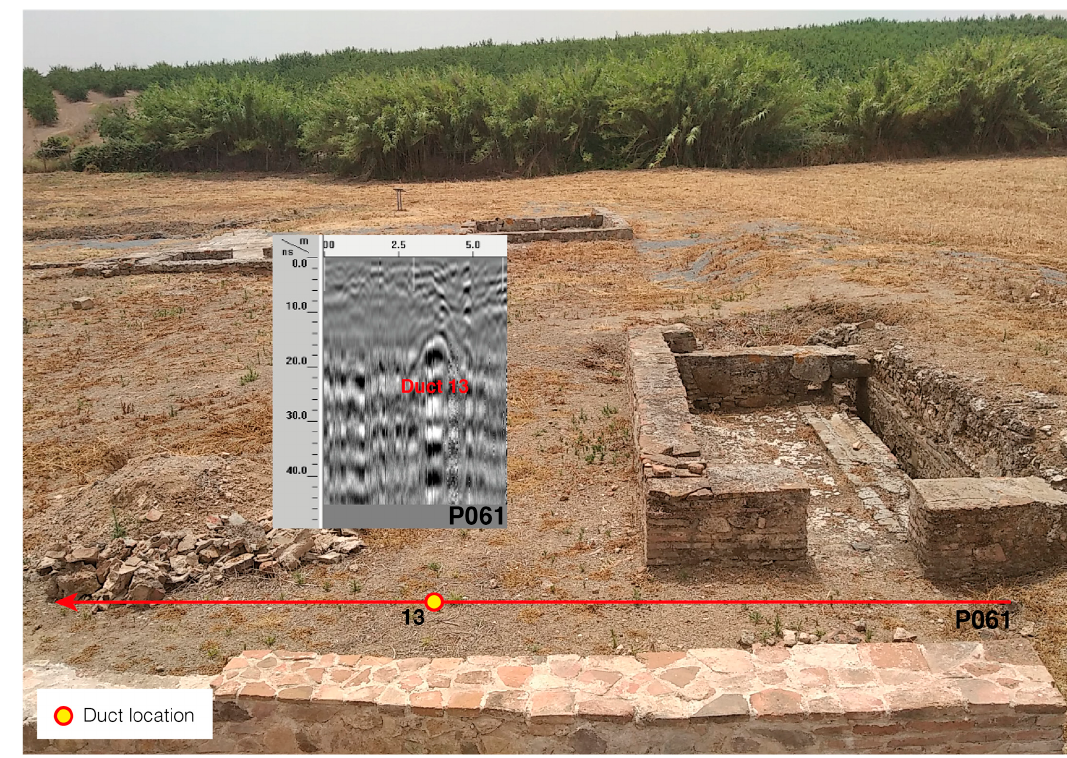
Figure 11. Representation of B-scan P061 and its location in the field.